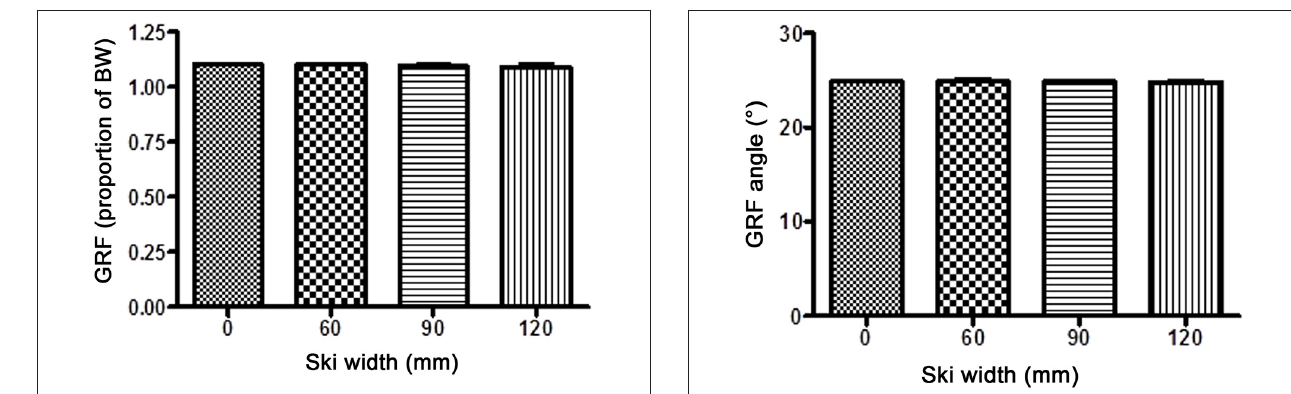
FIGURE 6 | The inclination of the ground reaction force (GRF; mean ± SD) with different waist widths for both knee flexion settings. Throughout the experiment, there were statistically insignificant changes from the preset GRF angle (25 ◦ from the vertical